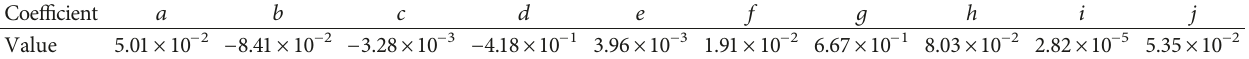
Table 5: Values of the undetermined coefficients.